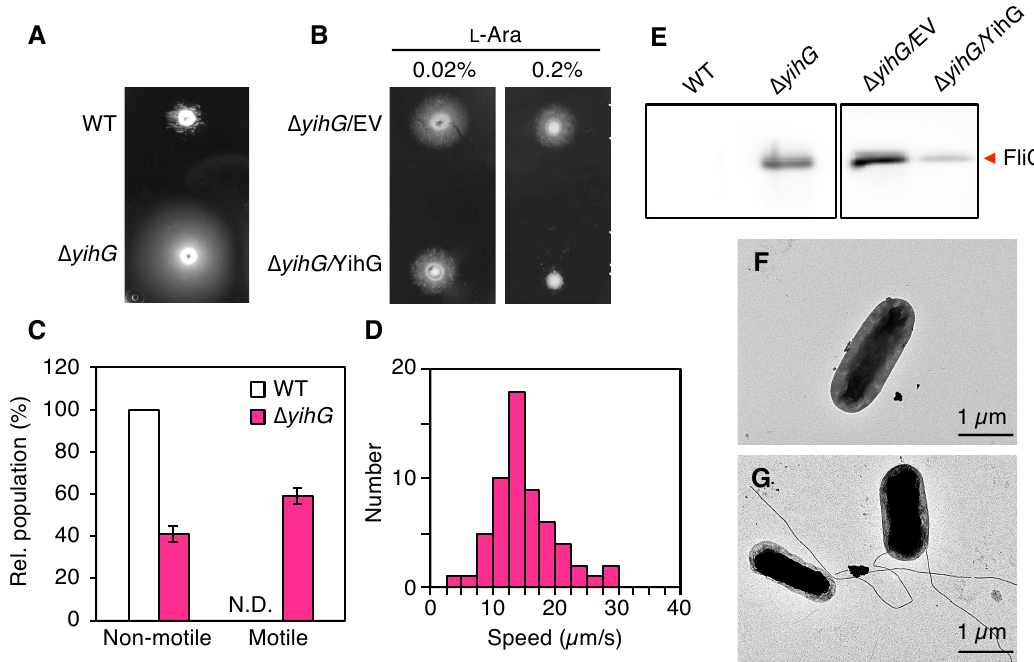
Figure 4. Characterization of the swimming motility of the E. coli cells. ( A ) Motilities of wild-type and ∆ yihG cells on the 0.2% agar plate. The plate was incubated at 37 ◦ C for 12 h. ( B ) Motilities of ∆ yihG cells harboring the pBAD-Cm R empty vector ( ∆ yihG / EV) or pBAD / yihG-his the 0.2% agar plates containing 0.02% or 0.2% l -arabinose. The plates were incubated at 37 ◦ C for 15 h. ( C ) Motility of the E. coli cells in solution. Wild-type (white) and ∆ yihG (pink) cells were grown